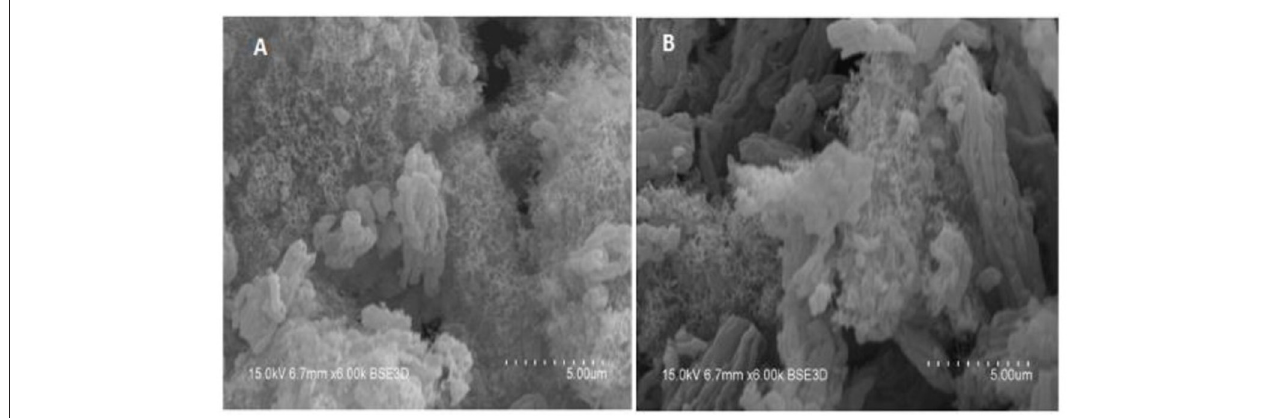
FIGURE 8 | SEM images of fresh samples 12COIMPNi11CoN-C (A) and 4COIMPNi12LaN-B (B) .